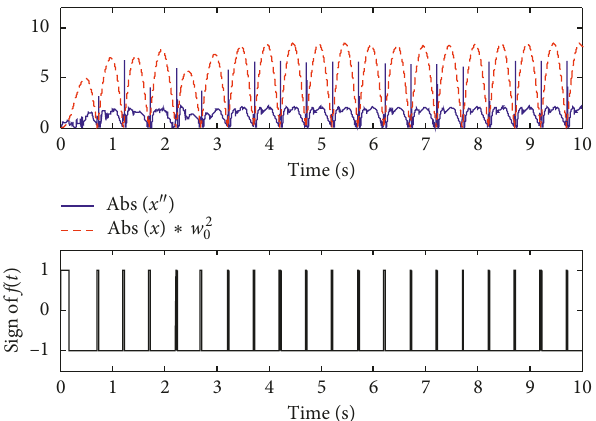
Figure 11: Results of F ( t ) frequency-range selector for the sem- iactive suspension when excitation frequency is 2 π .